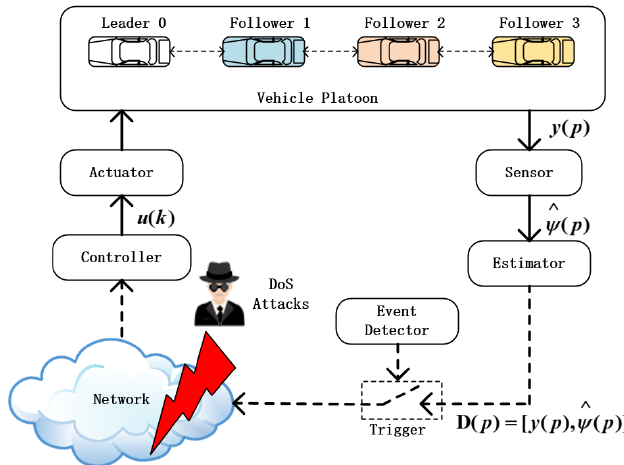
Figure 1. System framework with DoS